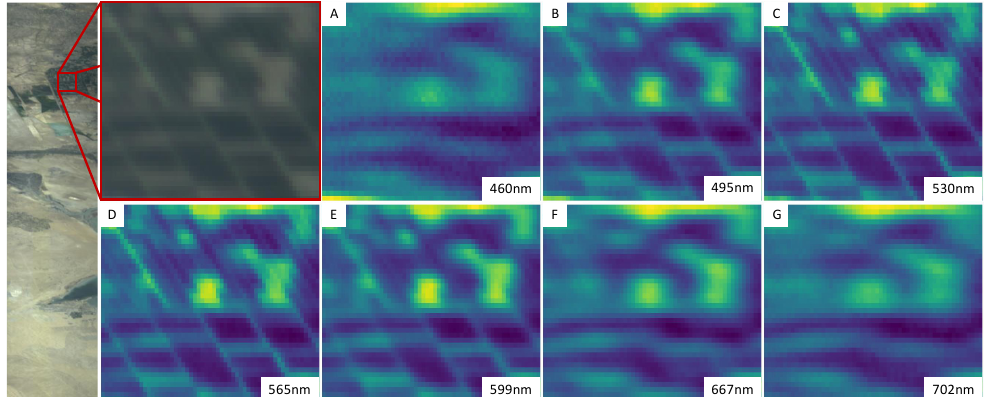
Figure 5. A qualitative look at the image cube’s sharpness at different wavelengths. The bands used for the RGB composite representation are 602.5 nm, 565 nm and 498.4 nm, respectively. Reductions in GRD at higher and lower wavelengths shown in Figure 6 are visible (See subfigures ( A , F , G )). The resolution is worse, mostly in the across-track direction, characteristic of a push-broom scan with little